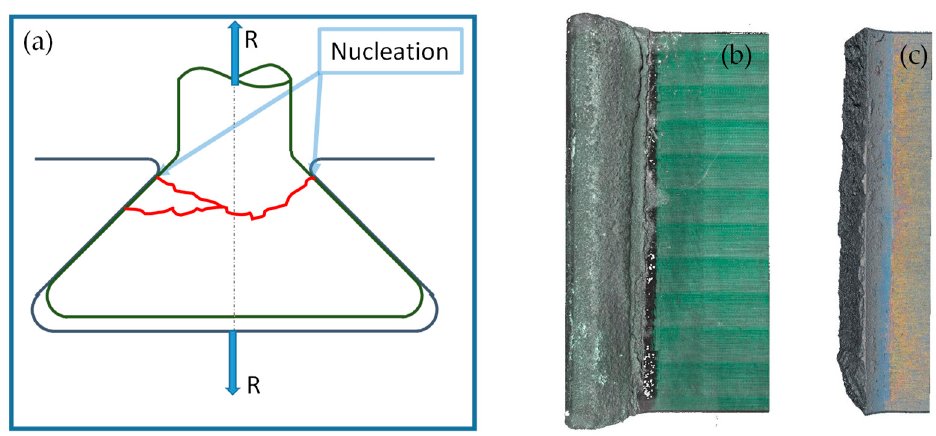
Figure 6. Crack evolution and optical topography of specimen: ( a ) typical fracture nucleation and propagation; ( b ) before fretting fatigue test; ( c ) fretting fatigue test.